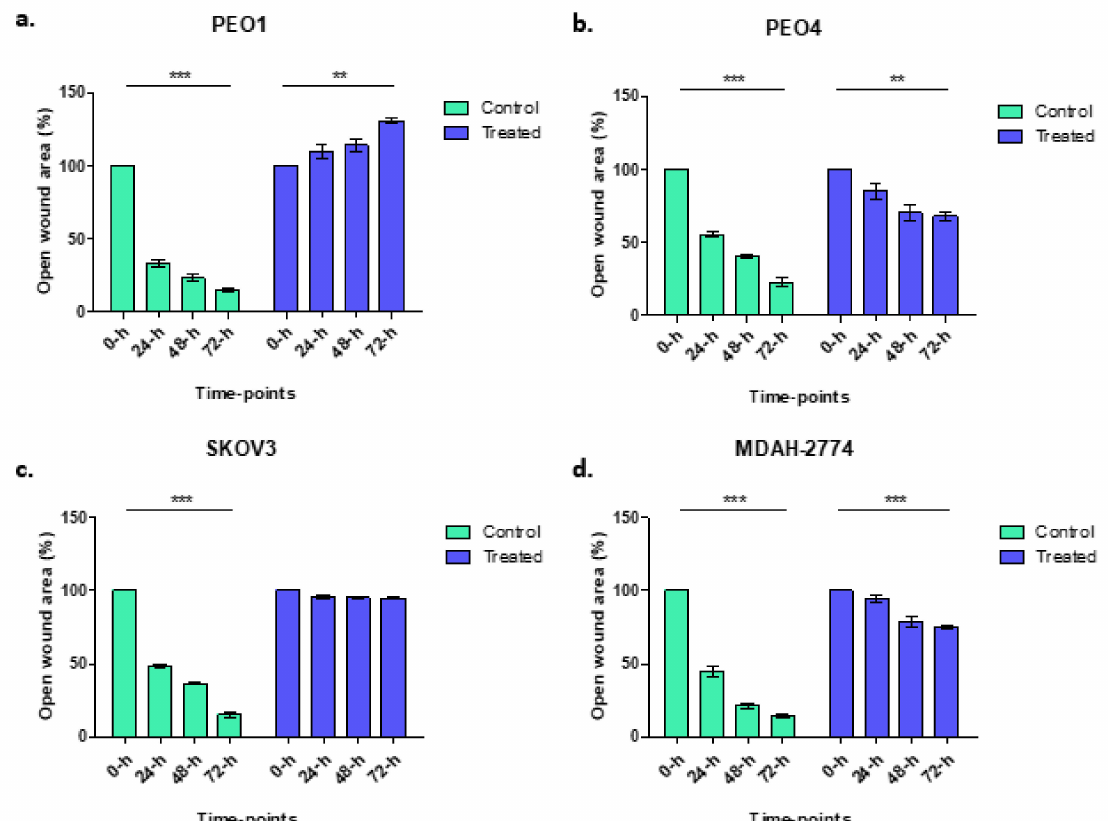
Figure 2. Control samples (green columns) from wound healing assays demonstrate gap closure where cells grow and migrate. Gap areas in the wound assays for all controls, irrespective of cell line, were significantly larger at 0 h than 72 h (*** p < 0.0001). There was no significant change in gap size after rucaparib treatment in SKOV3 cells (treated: p = 0.1088, BRCA2 wt, panel c ). There was an increase in gap area following rucaparib treatment BRCA2m PEO1 cells (panel a ) (** p = 0.0018). Rucaparib-treated PEO4 and MDAH-2774 cell lines (panels b and d , BRCA2 wt), demonstrated a reduction in open wound area although not as great as control samples (PEO4 ** p = 0.0059, MDAH-2774 *** p =